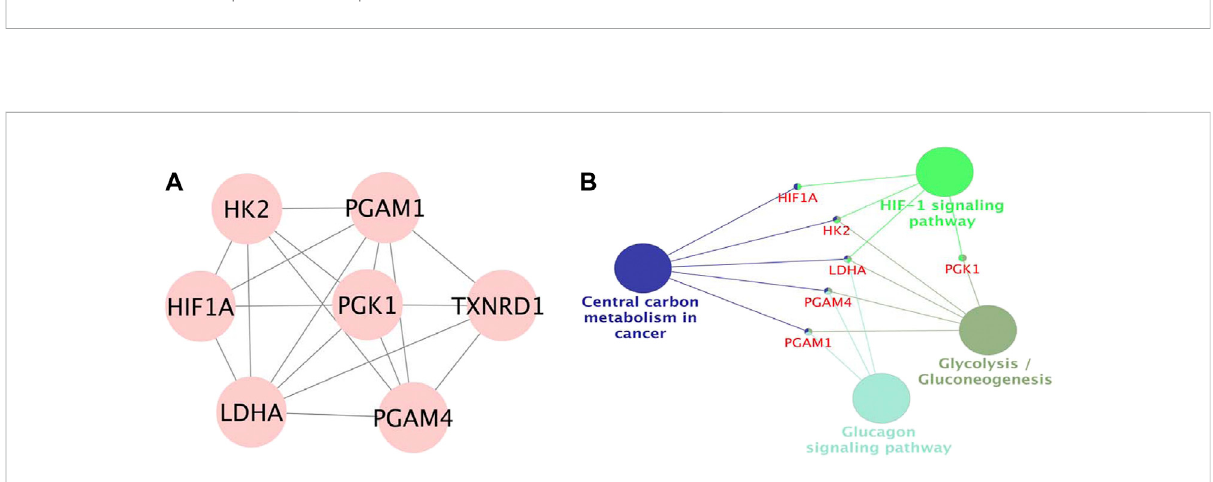
PPI Network, including 133 nodes and 186 edges. The color of a node depends on its degree; the darker the color, the higher the connectivity. Nodes in darker color represent their importance to the network.